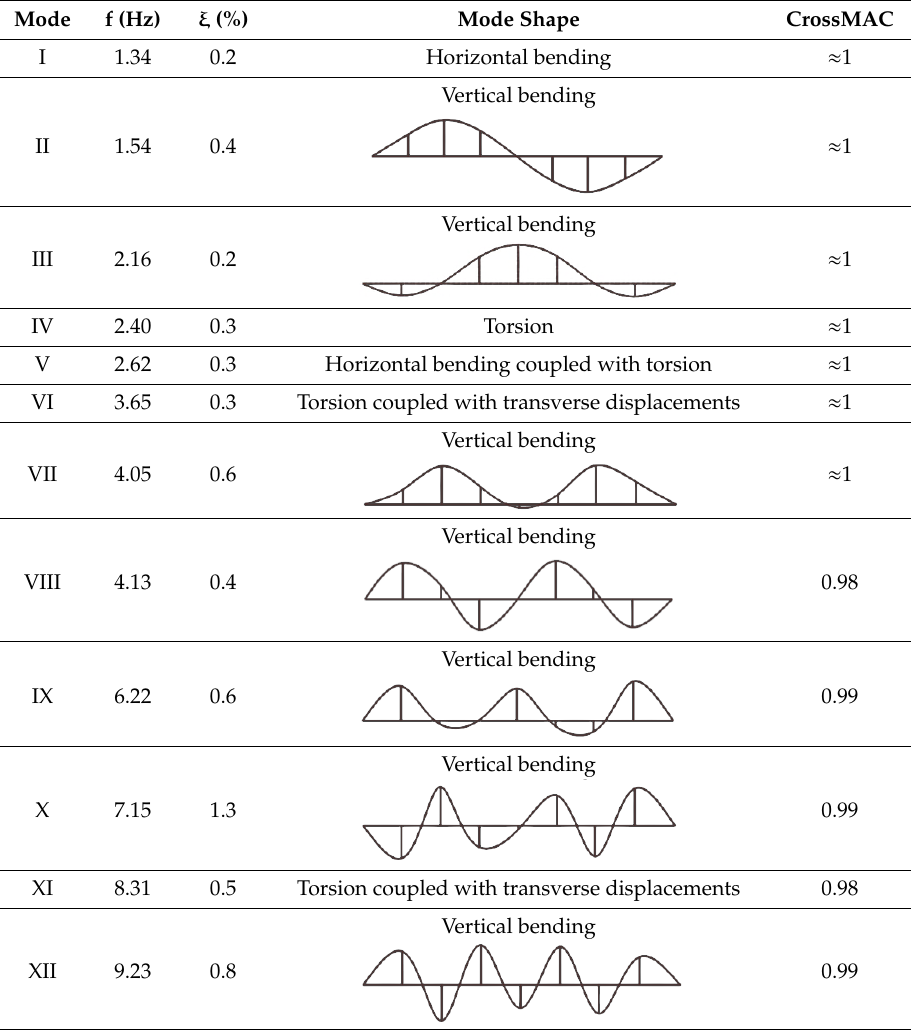
Figure 7. “Ospedale del Mare” footbridge: singular value plots (continuous colored lines) and identified frequencies (dashed lines). Table 5. “Ospedale del Mare” footbridge: output-only modal identification results.